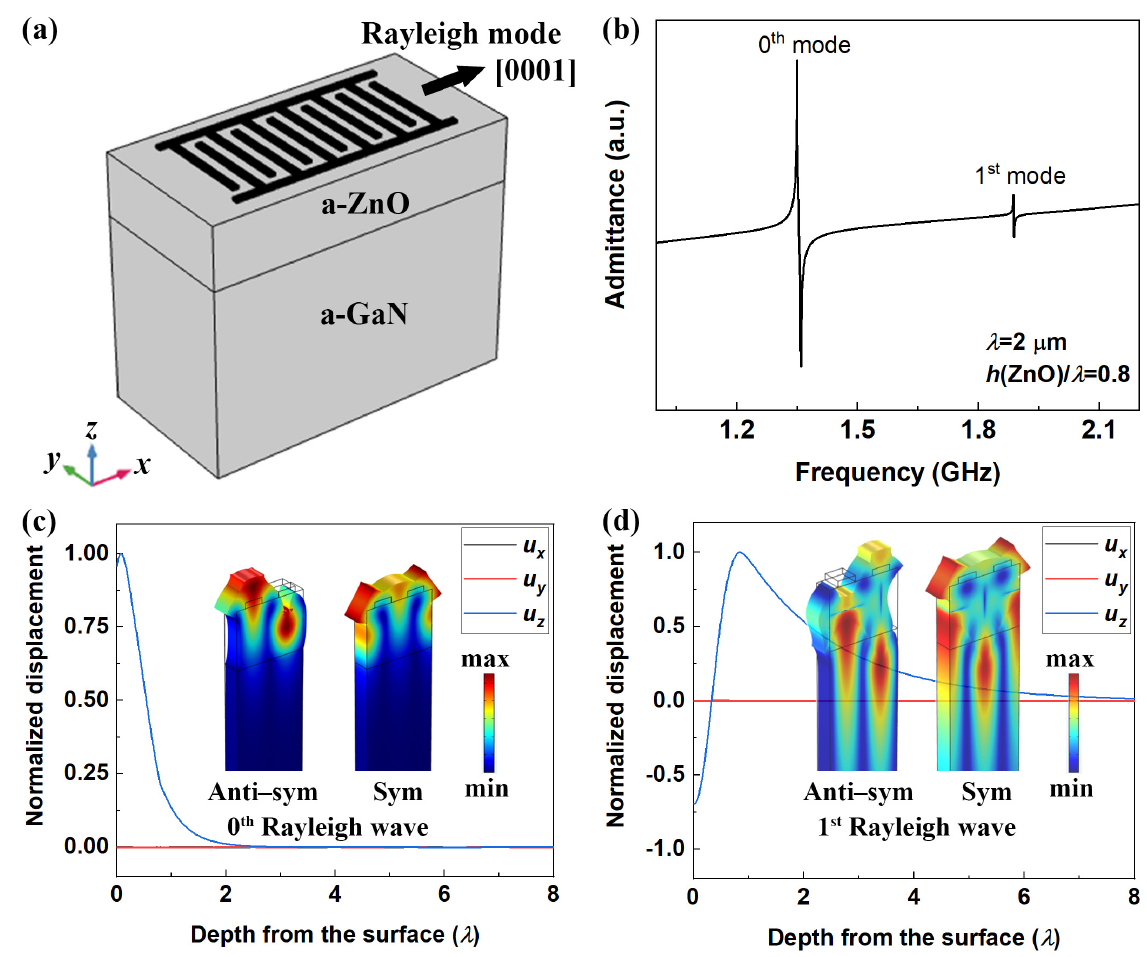
Figure 2. A typical admittance response ( b ) and its corresponding displacement curves and deformation shapes ( c , d ) of the SAW devices based on the a-ZnO/a-GaN structure ( a ) where Rayleigh-mode waves are excited.